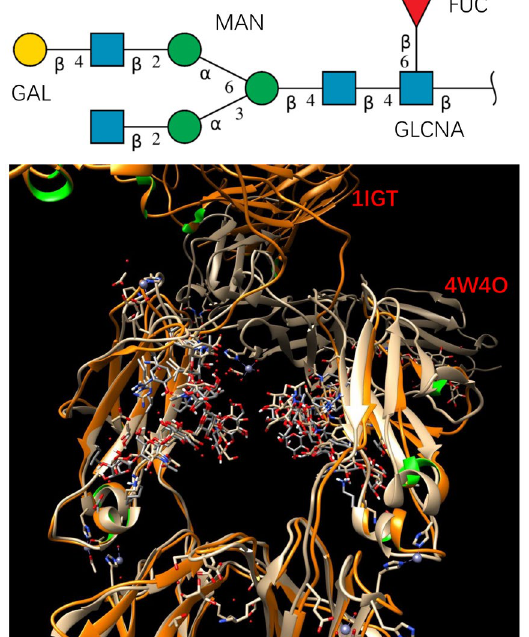
Figure 1. The studied glycan has stable conformation in free antibody and in the Fc-hFcγRI complex. Top panel: glycan sequence. Bottom panel: superimposing the crystal structures of a full antibody (PDB code: 1IGT) and Fc-hFcγRI complex (PDB code: 4W4O). Proteins are represented by ribbons, and the glycans are shown as sticks. GAL: Galactose; MAN: mannose; FUC: